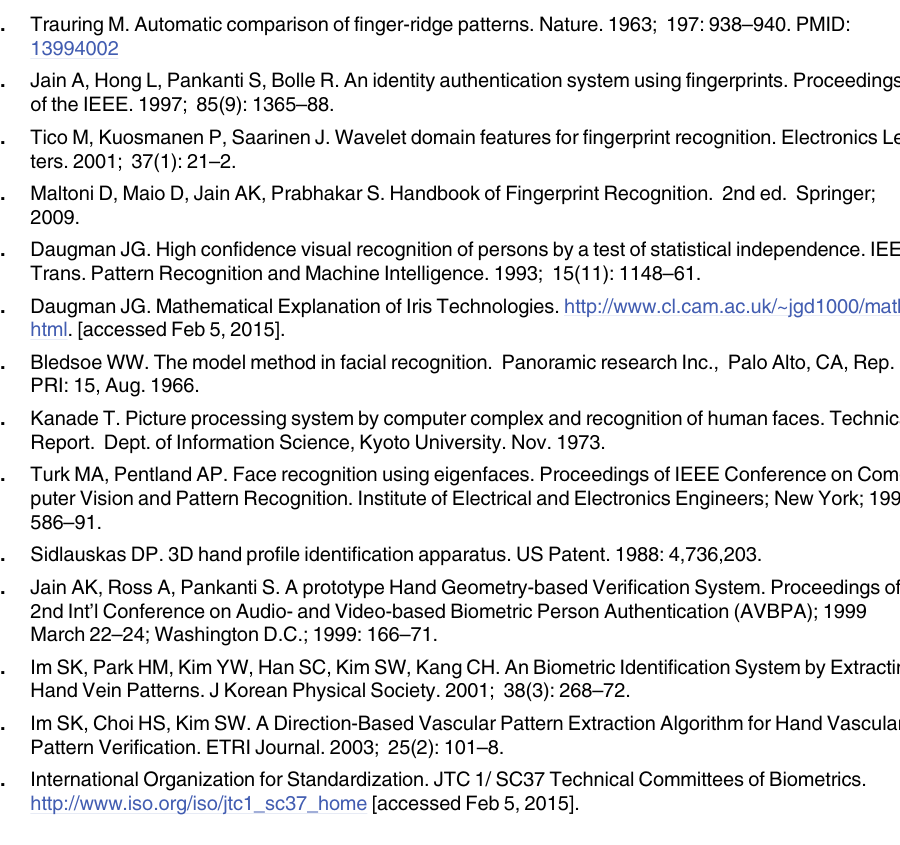
S1 Table. Multiple comparisons by Wilcoxon rank-sum test on SSc, SS, MCTD, and SLE patients ’ C values